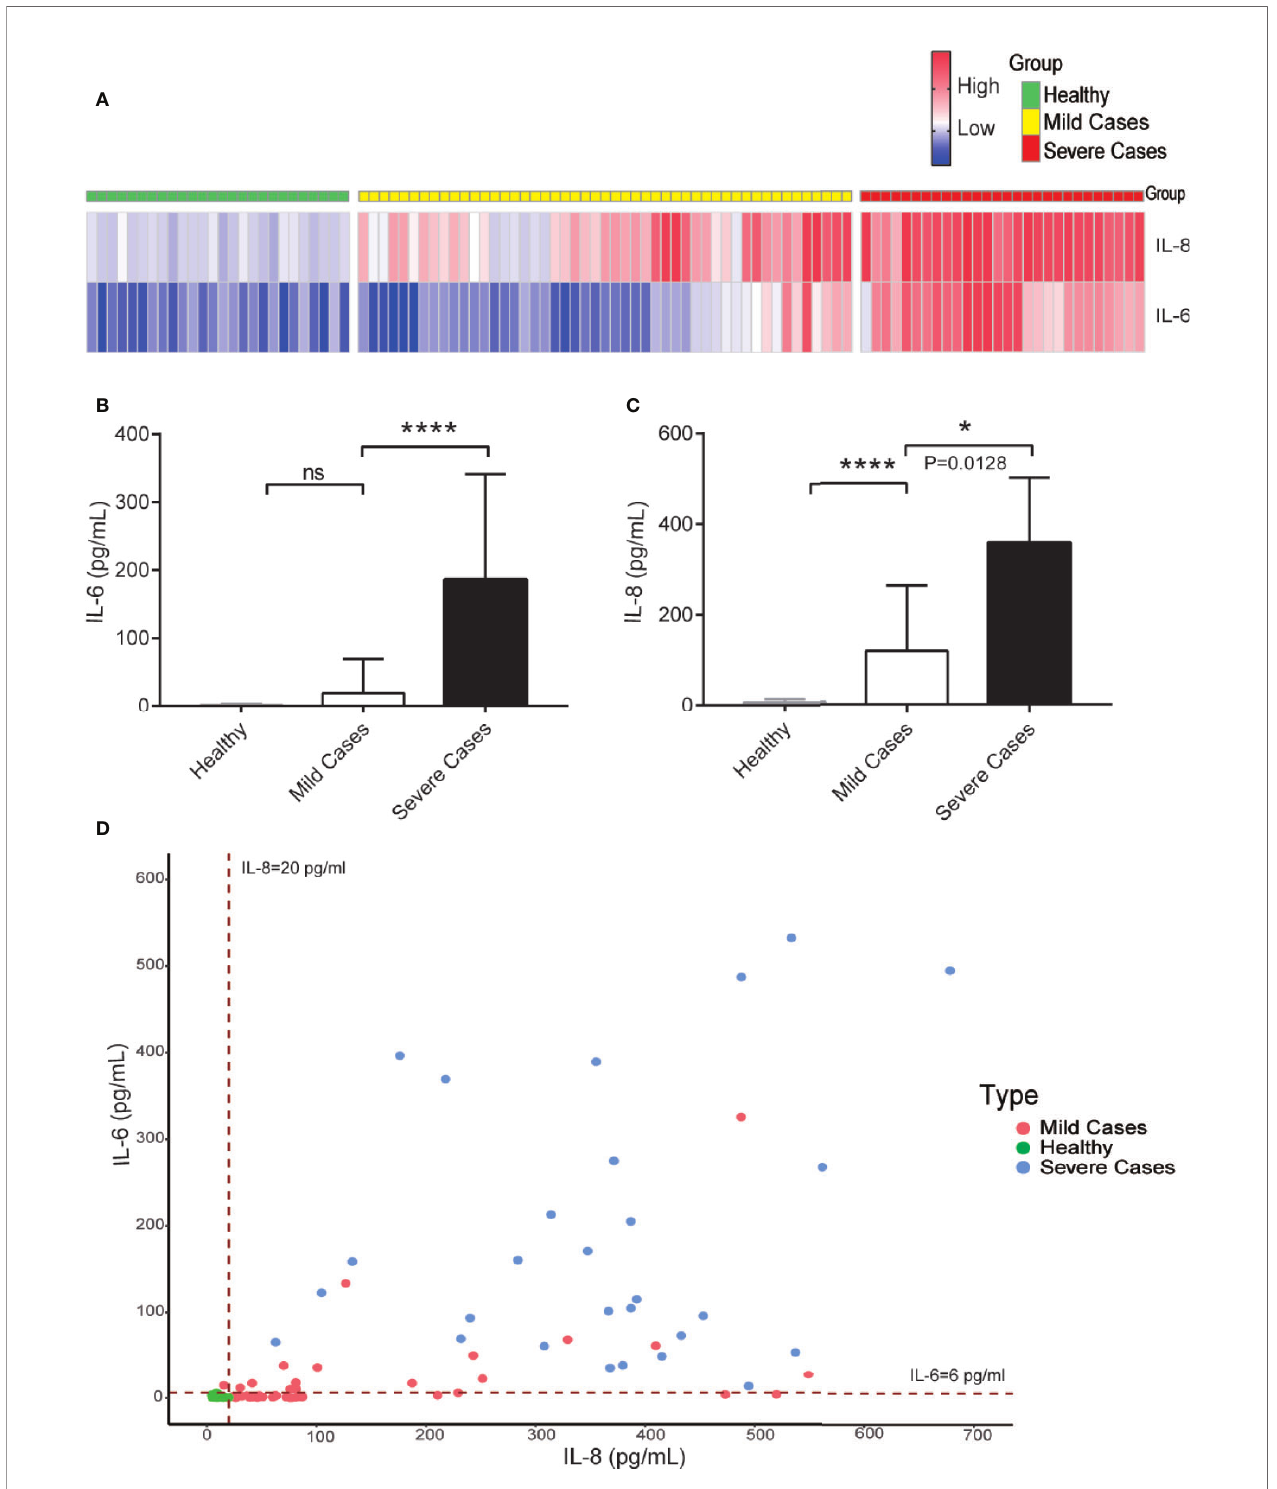
FIGURE 4 | While IL-6 represents for COVID-19 patients with severe disease conditions, IL-8 is a better indicator of overall COVID-19 diseases. (A) Heatmap of IL-6 and IL-8 levels from COVID-19 patients during different clinical stages. (B, C) The IL-6 (B) and IL-8 (C) levels among different COVID-19 patient groups. (D) Distribution of IL-6 and IL-8 levels among different COVID-19 patient groups. Dashed lines indicate the lower limit of detection for the ELISA. ELISA data (B, C) are shown as Mean±SEM, * p <0.05, **** p <0.0001, unpaired Student t